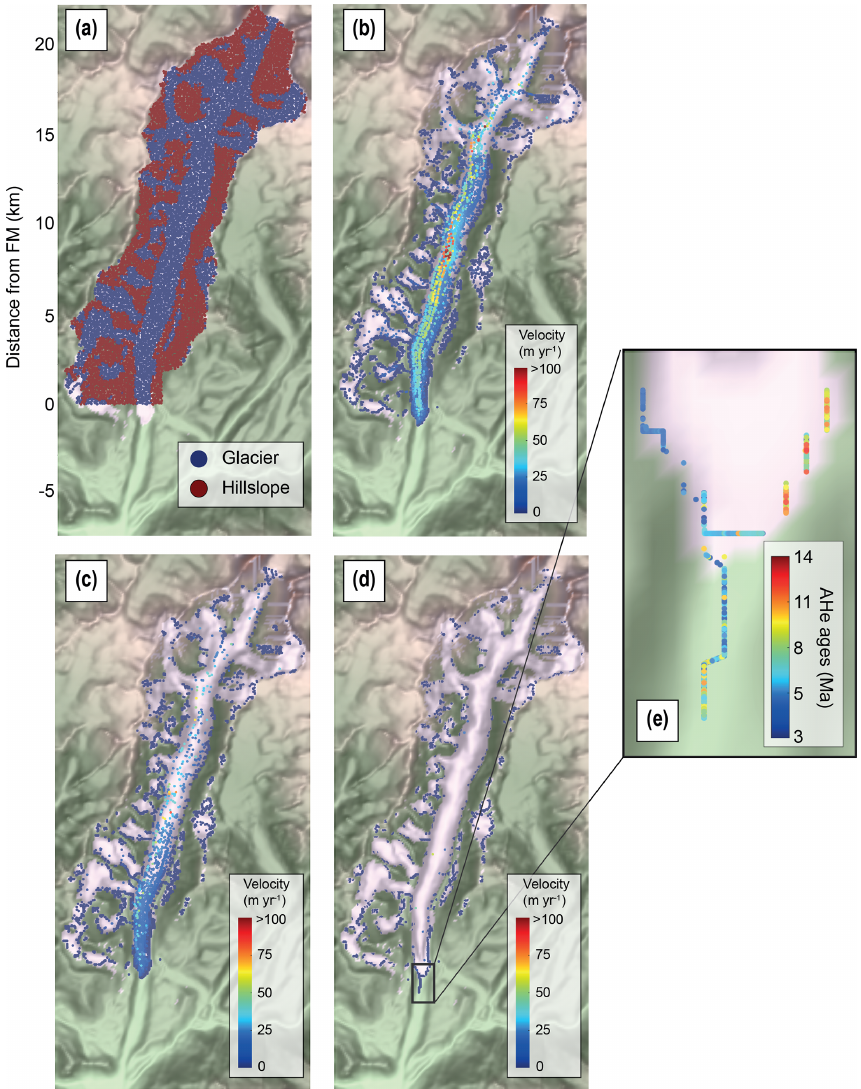
Figure 5. Kinematics of particle transport. Particles have been uniformly produced across the catchment and transported. (a) Sources of particles; red dots and blue dots are particles originating from the hillslope and glacier at the beginning of the model simulation, respectively. (b) Particle velocity at time 500yr, (c) at time 1000yr, and (d) at time 8500yr. AHe ages in the frontal moraine (FM) are shown in (e) ; see also the inset in (d)